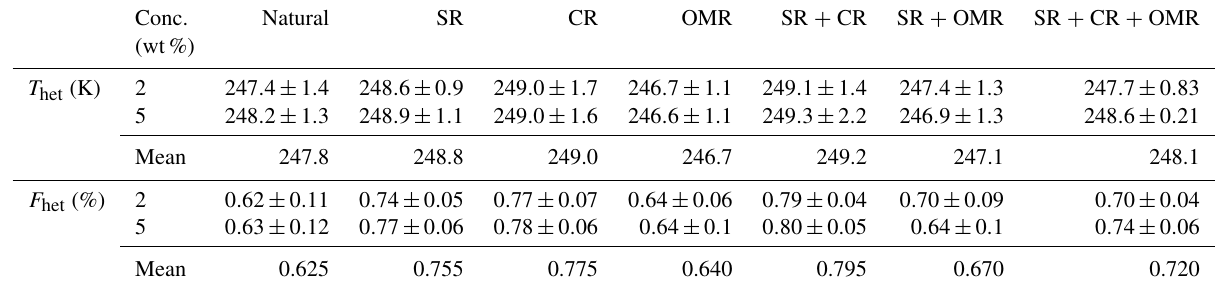
Figs. 4, 5, A2, and A3 in Appendix A). For the 5 wt % con- centration, (cid:49)T het(OMR-natural) was negative for all samples, with an average decrease of 1.5 K. For the 2 wt % samples, (cid:49)T het(OMR-natural) ranged between − 2 . 5 and 1 K, with an av- erage of (cid:49)T het(OMR-natural) = − 0 . 7 K. Soil Sa, which exhib- ited the strongest shift to lower temperatures after organics removal ( (cid:49)T het(OMR-natural) = − 2 . 9 K), had the highest